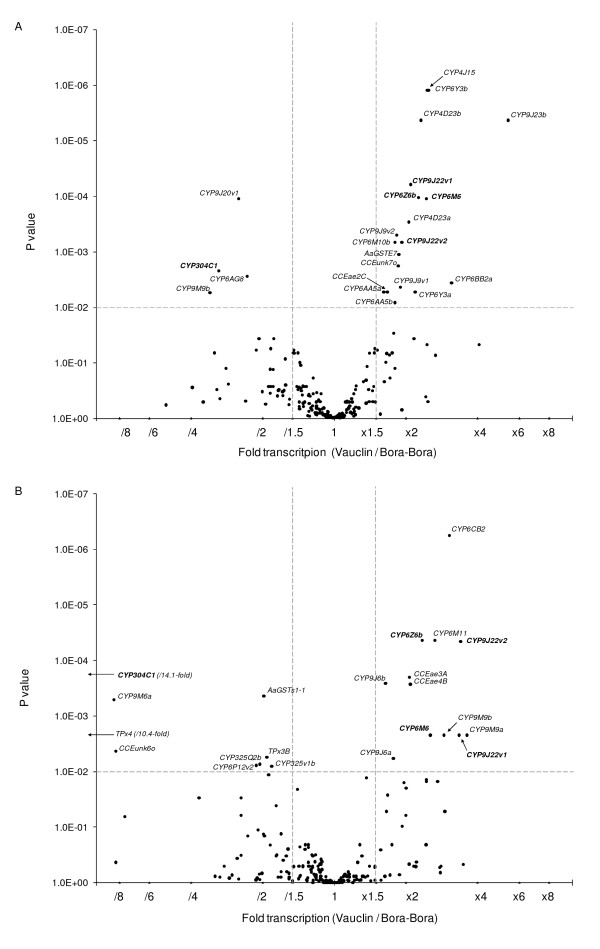
Microarray screening of detoxifications genes differentially transcribed in the insecticide-resistant strain Vauclin. Differential transcription of detoxification gens was investigated separately in 4th-stage larvae (A) and 3-days old adults (B). For each life stage, differences in gene transcription are indicated as a function of both transcription ratio (Vauclin/Bora-Bora) and ratio's significance (t-test P values). For each comparison, only probes showing consistent data in at least 3 hybridisations out of 6 were considered. Vertical lines indicate 1.5-fold transcription difference in either direction. Horizontal line indicates significance threshold (p < 0.01) adopted for the one sample t-test after Benjamini and Hochberg multiple testing correction procedure. Probes showing both more than 1.5-fold differential transcription and a significant P value are named. Probes that were found under- or over-transcribed in both larvae and adults are shown in bold. Suffixes a and b represent two different probes of the same gene while suffixes v1 and v2 represent two different alleles of the same gene.